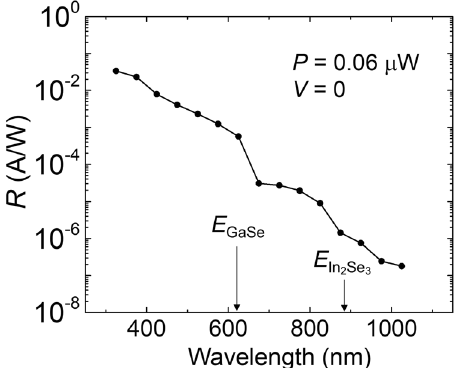
Fig. 3 Wavelength-dependent photoresponsivity. Dependence of the photoresponsivity ( R ) on the photon wavelength for a graphene contacted p -GaSe/ n -In 2 Se 3 junction (GaSe/In 2 Se 3 thickness ~30/ 30 nm) at V = 0 and power P = 0.06 μ W. The arrows indicate the band gap energies of GaSe and In 2 Se 3 ,